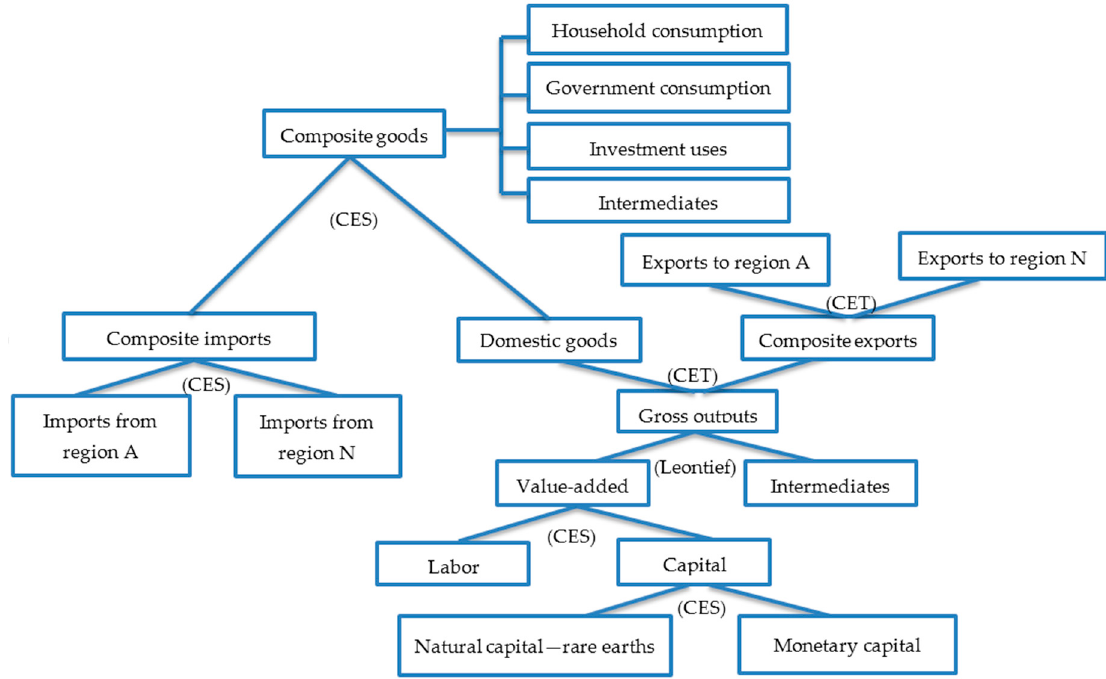
Figure 1. Structure of China’s DCGE model for forecasting rare earths (within a period).